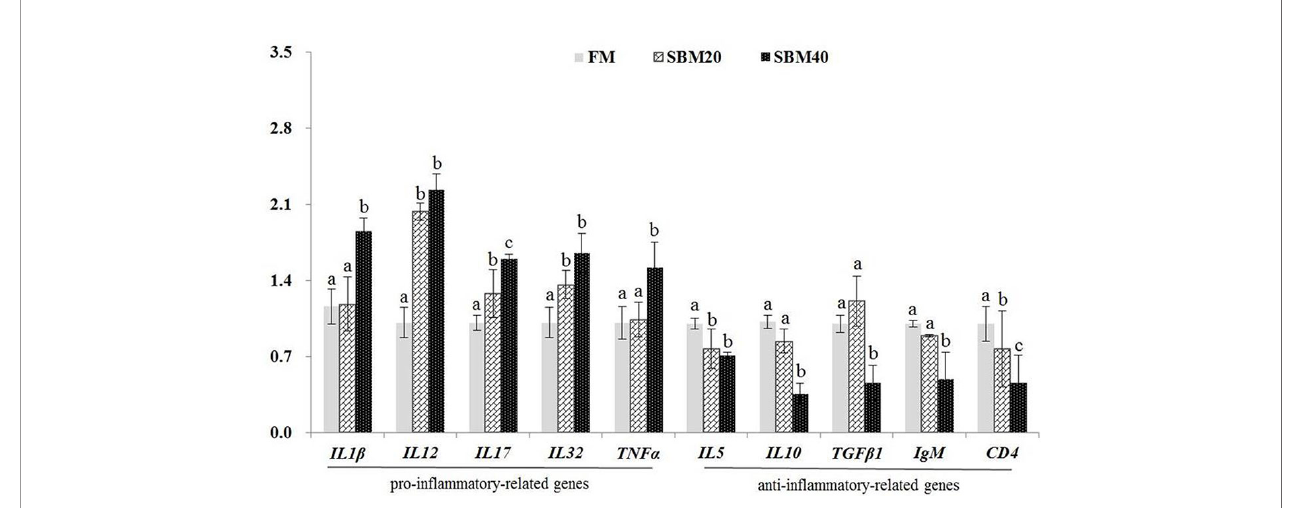
FIGURE 2 | Effect of soybean meal substitution for fi sh meal on the immune-related gene expressions in the distal intestine tissues of pearl gentian grouper ( n = 3). The different letters represent signi fi cant differences.